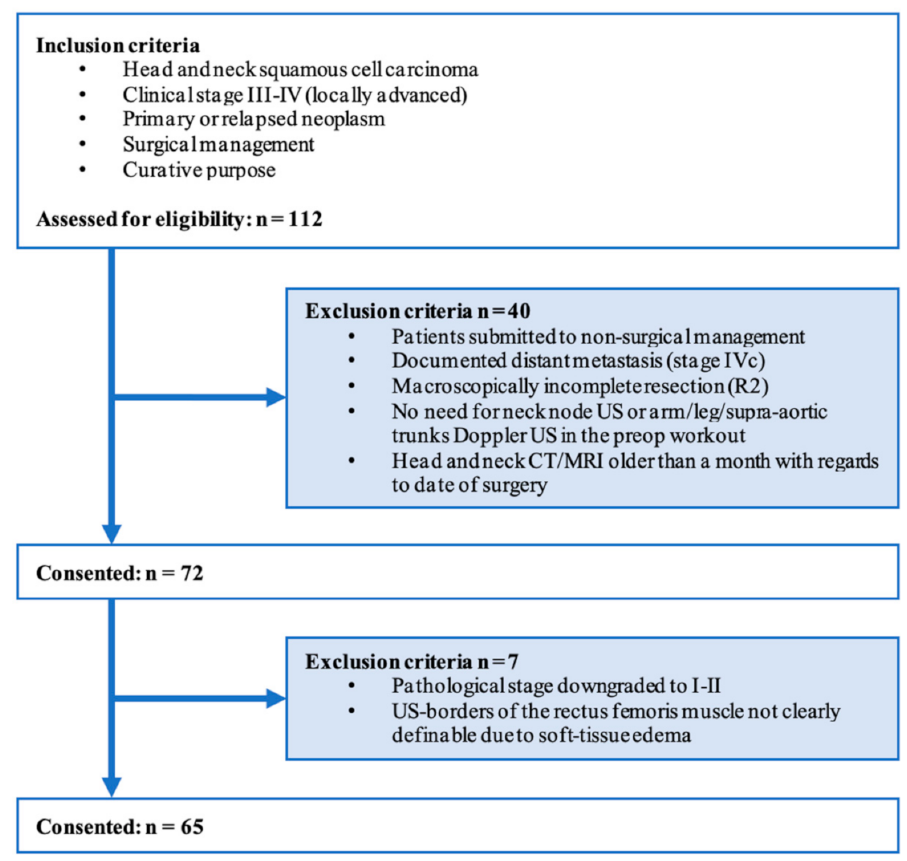
Figure 1. Study flow